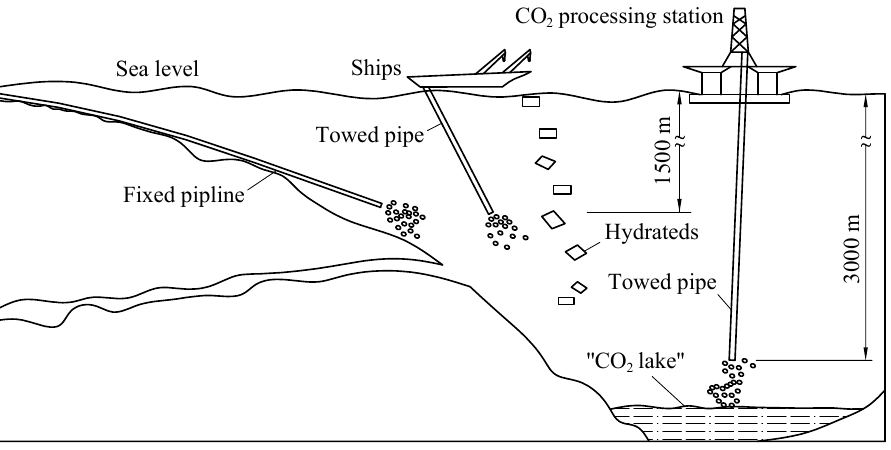
Figure 11. CO storage in a deep sea schematic 2